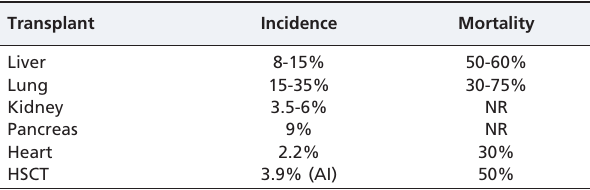
Table 1 - The incidence and mortality of fungal infections in patients who received a solid organ transplantation or BMT/HSCT